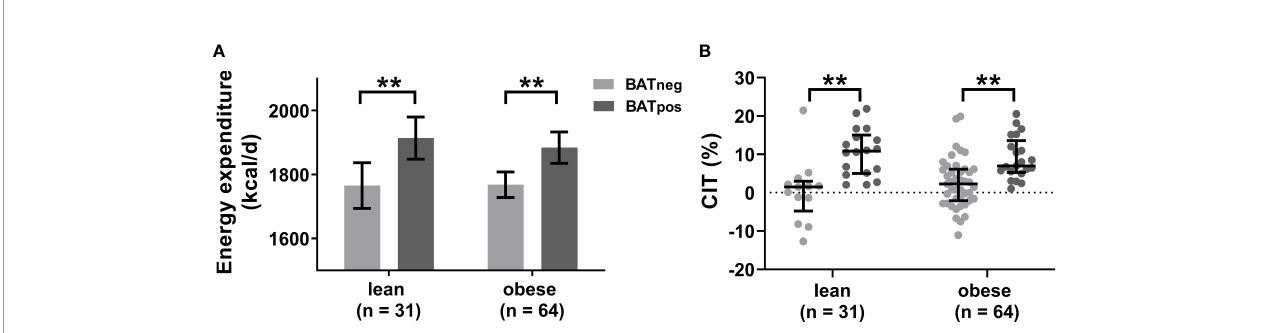
FIGURE 3 | Cold-induced energy expenditure is similar in leanness and obesity. Estimated mean cold-induced energy expenditure adjusted for lean body mass, fat mass, and resting energy expenditure (A) . The error bars indicated 95% con fi dence intervals. Comparison of cold-induced thermogenesis (CIT) as percent increase from resting energy expenditure between BAT neg and BAT pos individuals strati fi ed by weight status (B) . The graphs indicate median values and interquartile ranges. **p